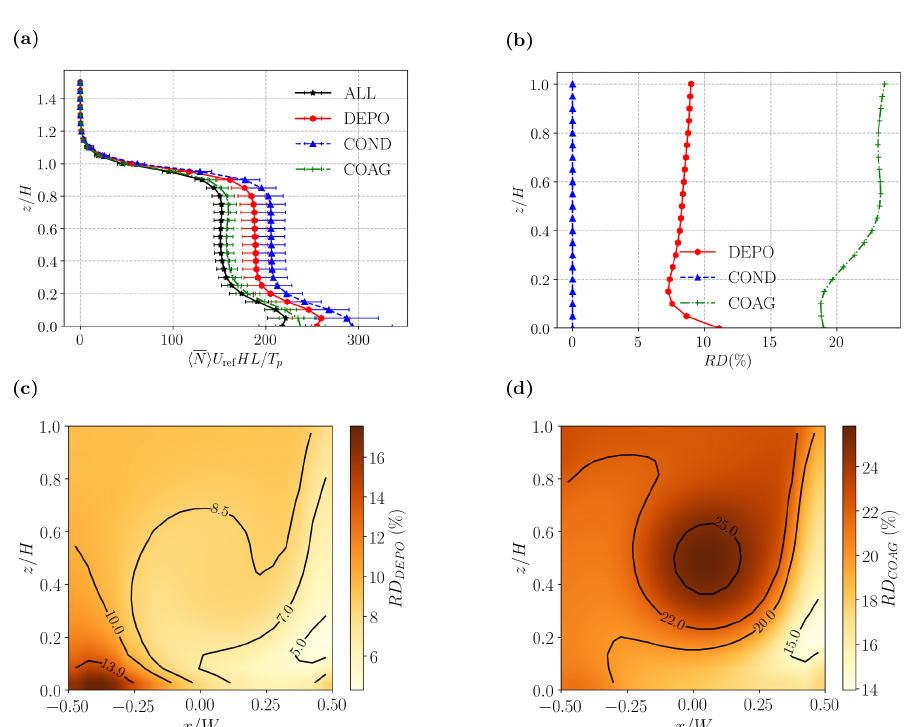
Figure 11. As in Fig. 9 but for Case CO-D.